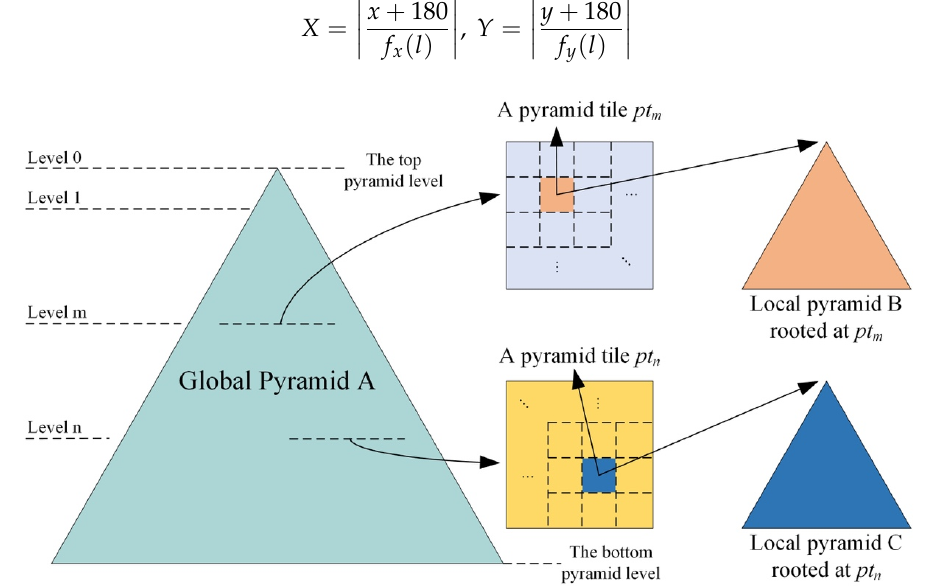
Figure 2. The relationship between the global pyramid and local pyramids.